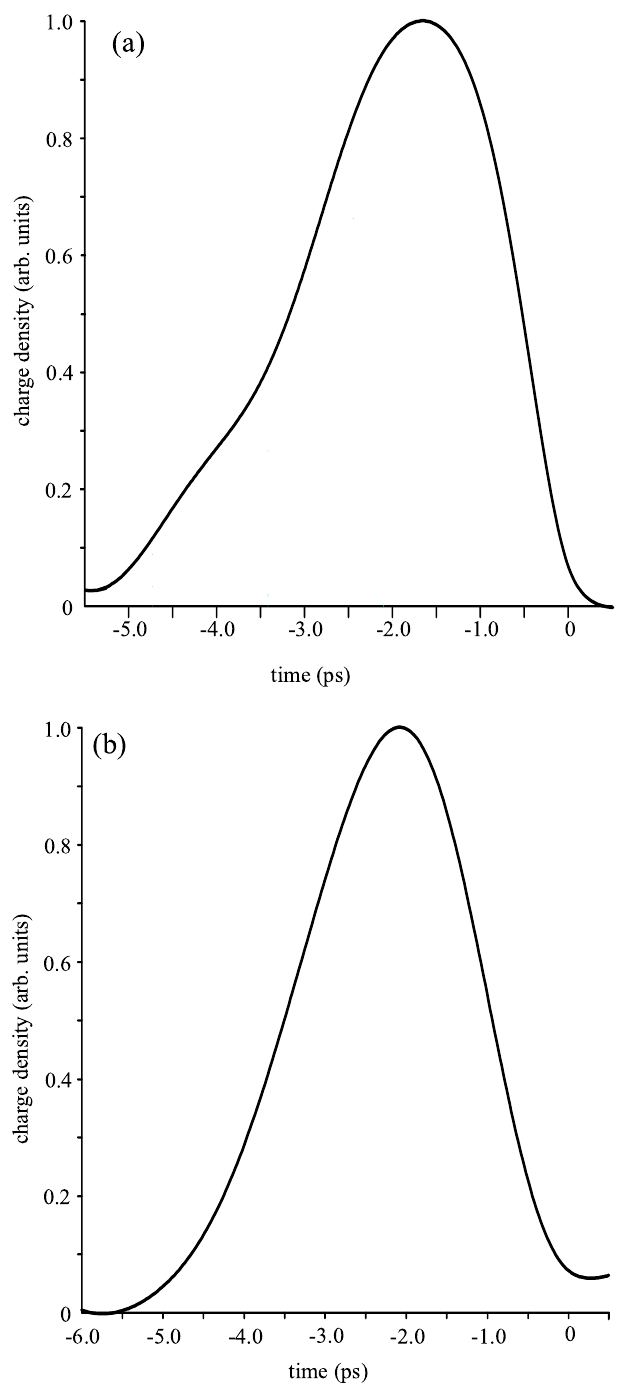
FIG. 8. (a) The reconstructed longitudinal profile correspond- ing to the data of: (a) Fig. 6(a) and (b) Fig. 6(b). The number of electrons per bunch was ffi 0 : 9 (cid:2) 10 10 and ffi 1 : 1 (cid:2) 10 10 , re-